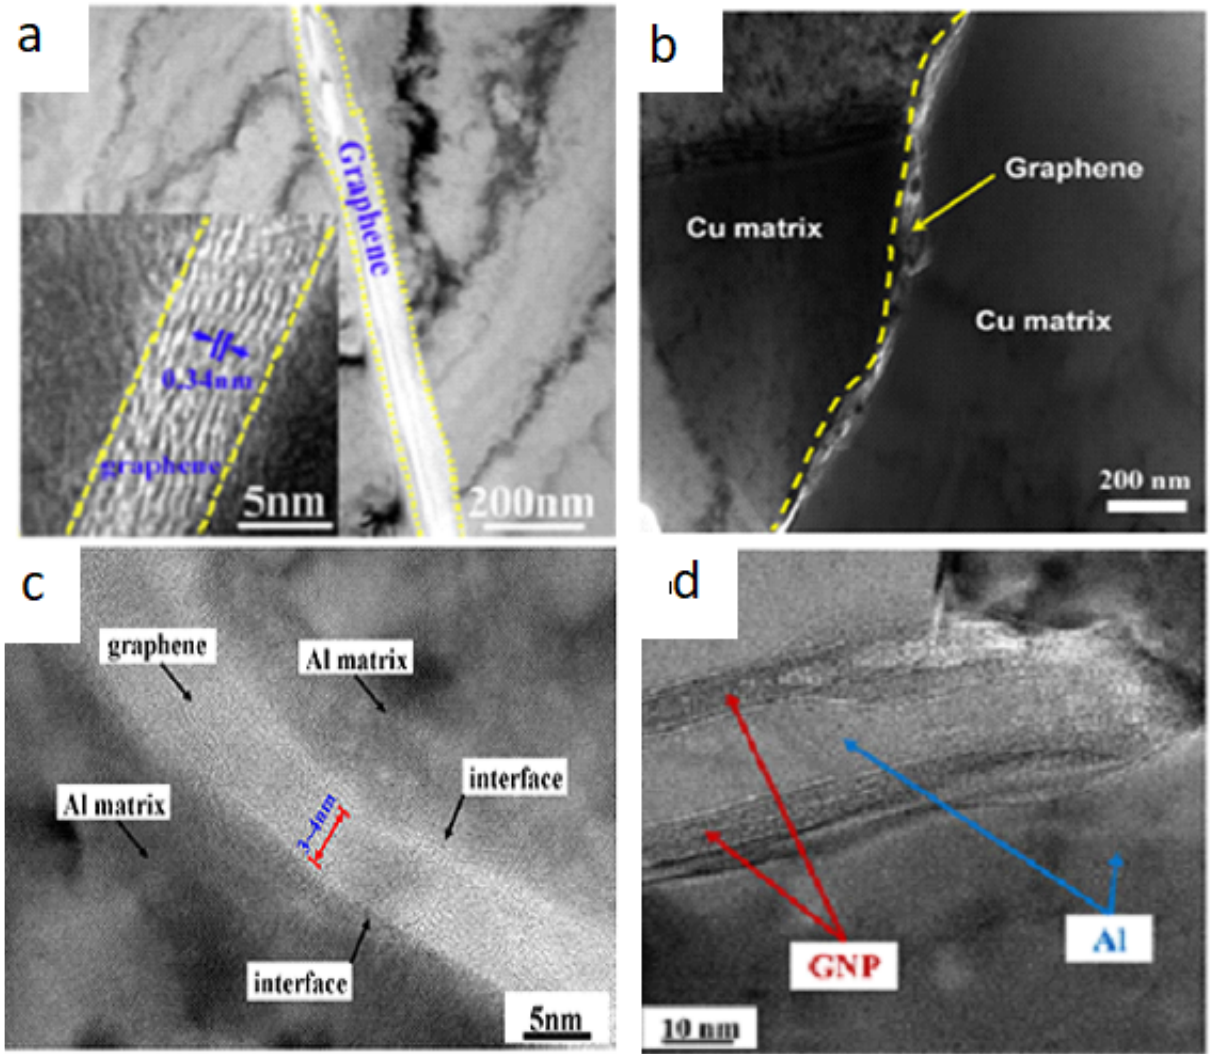
Figure 17: TEM images showing distribution of Gr sheets in (a, b) Cu matrix, and (c, d) Al matrix. Reproduced from References [49, 51, 57], and [54],